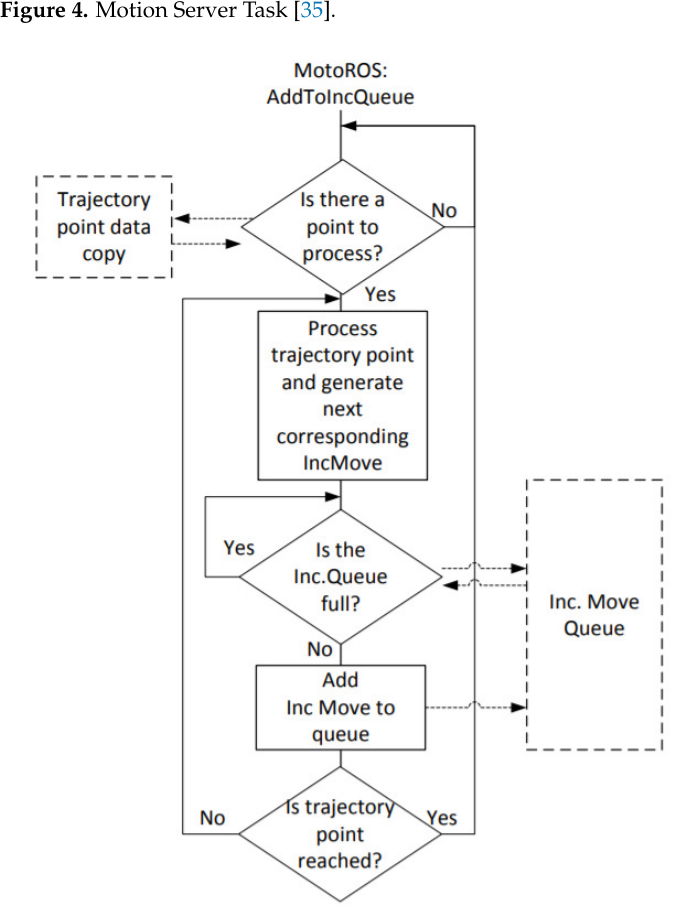
Figure 5. Add to Increment Move Queue Task